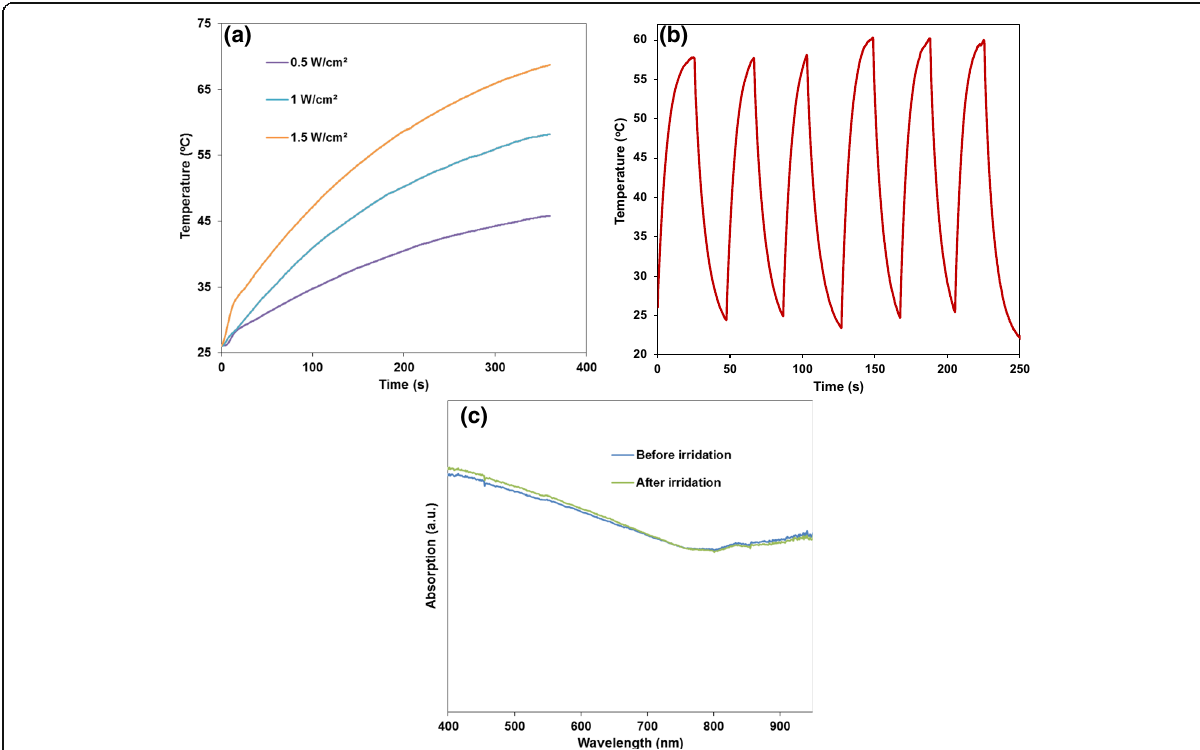
Fig. 6 a Photothermal behavior of 50 μ g/mL of FePt@PPy NPs kept under an 808-nm laser at different power densities for 6 min. b The real-time temperature record of six heating/cooling cycles of 50 μ g/mL of FePt@PPy NPs under an on/off laser experiment (1 W/cm 2 ). c UV-Vis-NIR spectra